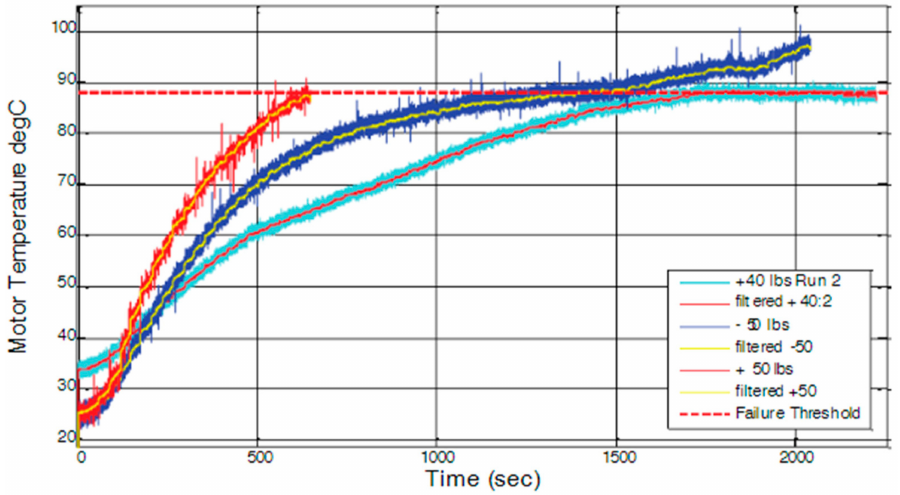
Figure 5. Plot of motor temperature against time showing run-to-failure